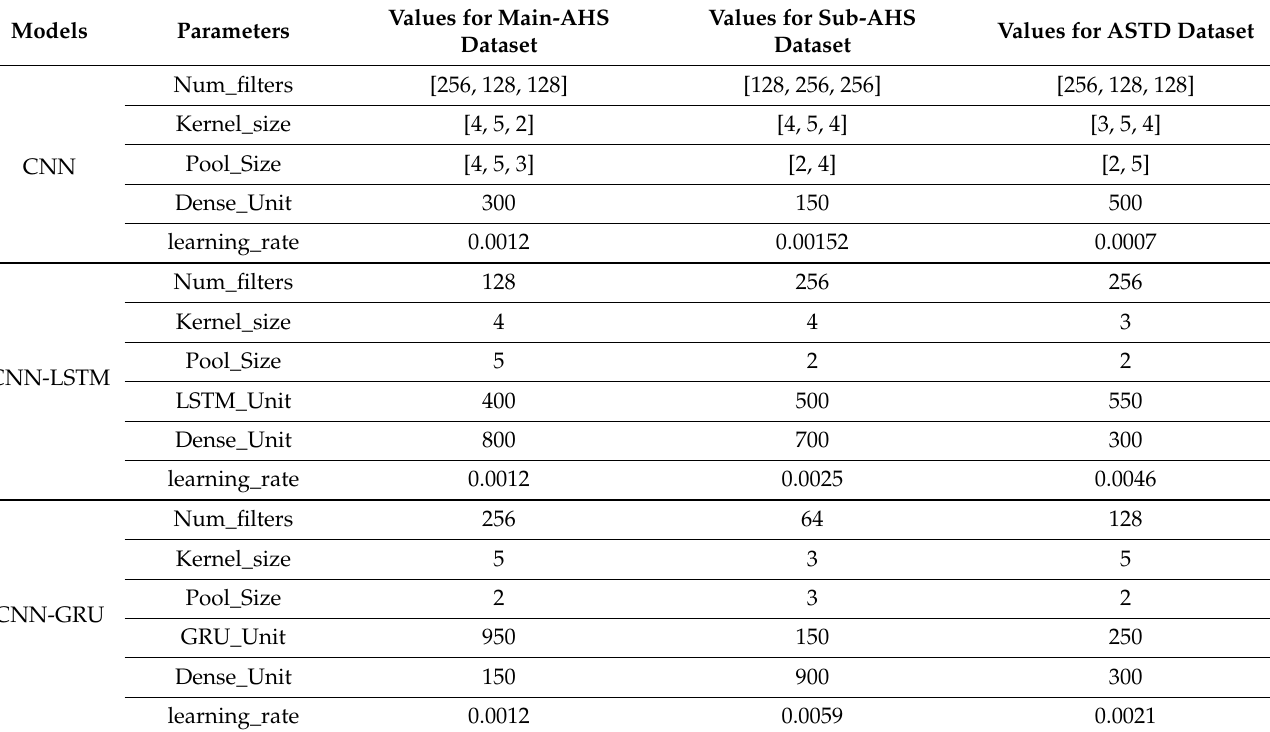
Table 2. Values of parameters after applying DeepCNN, CNN-LSTM and CNN-GRU with CBOW.